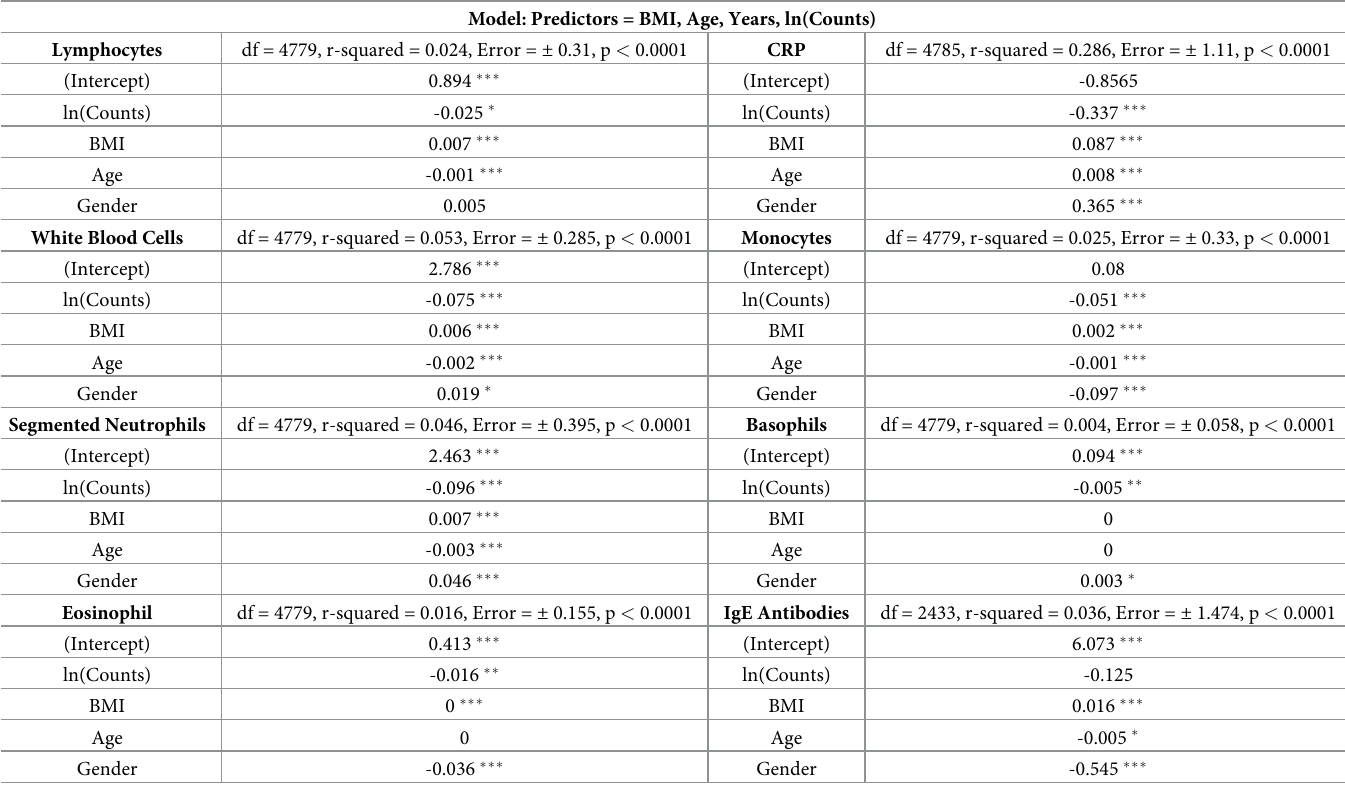
Asterisks next to values for individual variables indicate significance levels: � = p < 0.05, �� = p < 0.01, ��� = p <